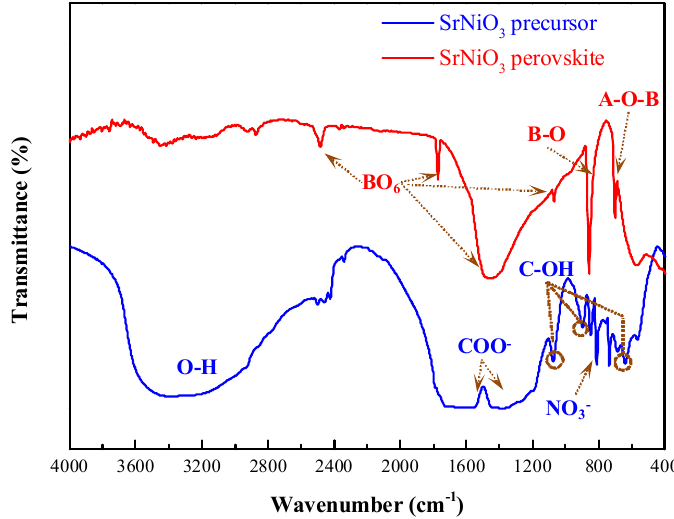
Figure 10. FT-IR spectra of SrNiO 3 perovskite and SrNiO 3 precursor.